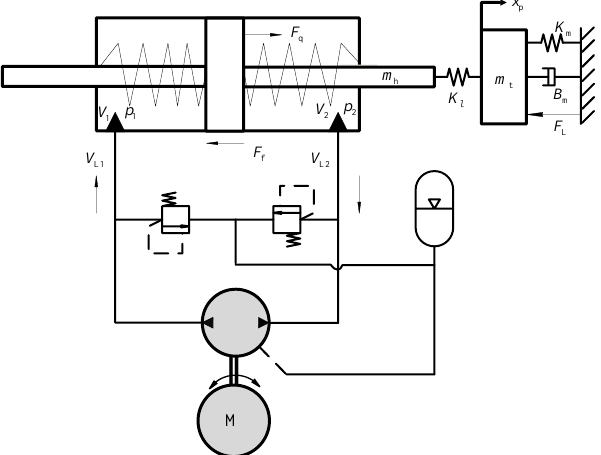
Figure 3. Schematic diagram of system mechanical – hydraulic coupling.